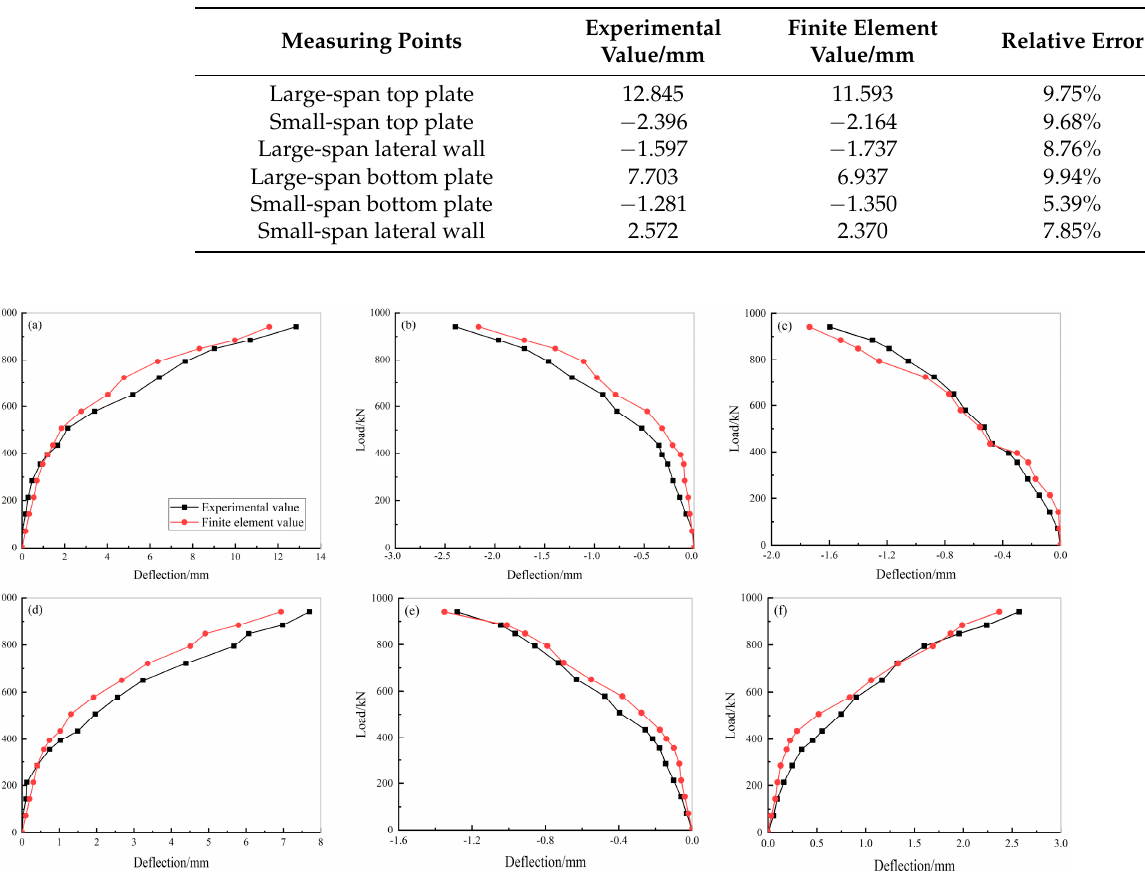
Figure 12. Load-deflection curves of prefabricated underground utility tunnel: ( a ) load-deflection curve of large-span top plate; ( b ) load-deflection curve of small-span top plate; ( c ) load-deflection curve of large-span lateral wall; ( d ) load-deflection curve of large-span bottom plate; ( e ) load-deflection curve of small-span bottom plate; and ( f ) load-deflection curve of small-span lateral wall. Table5. Midspan deflection value.